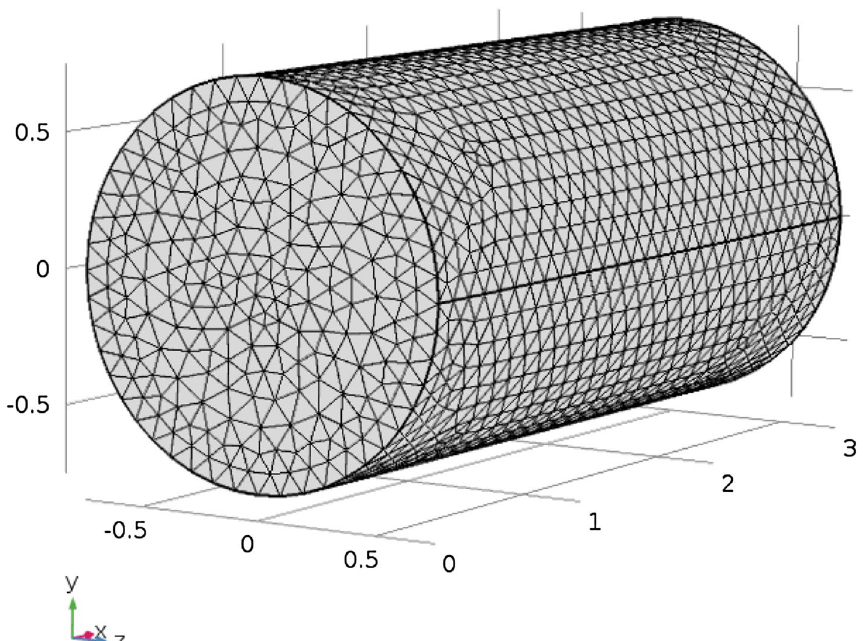
Fig. 1 The meshing of the geometry using extra-fine ele- ment